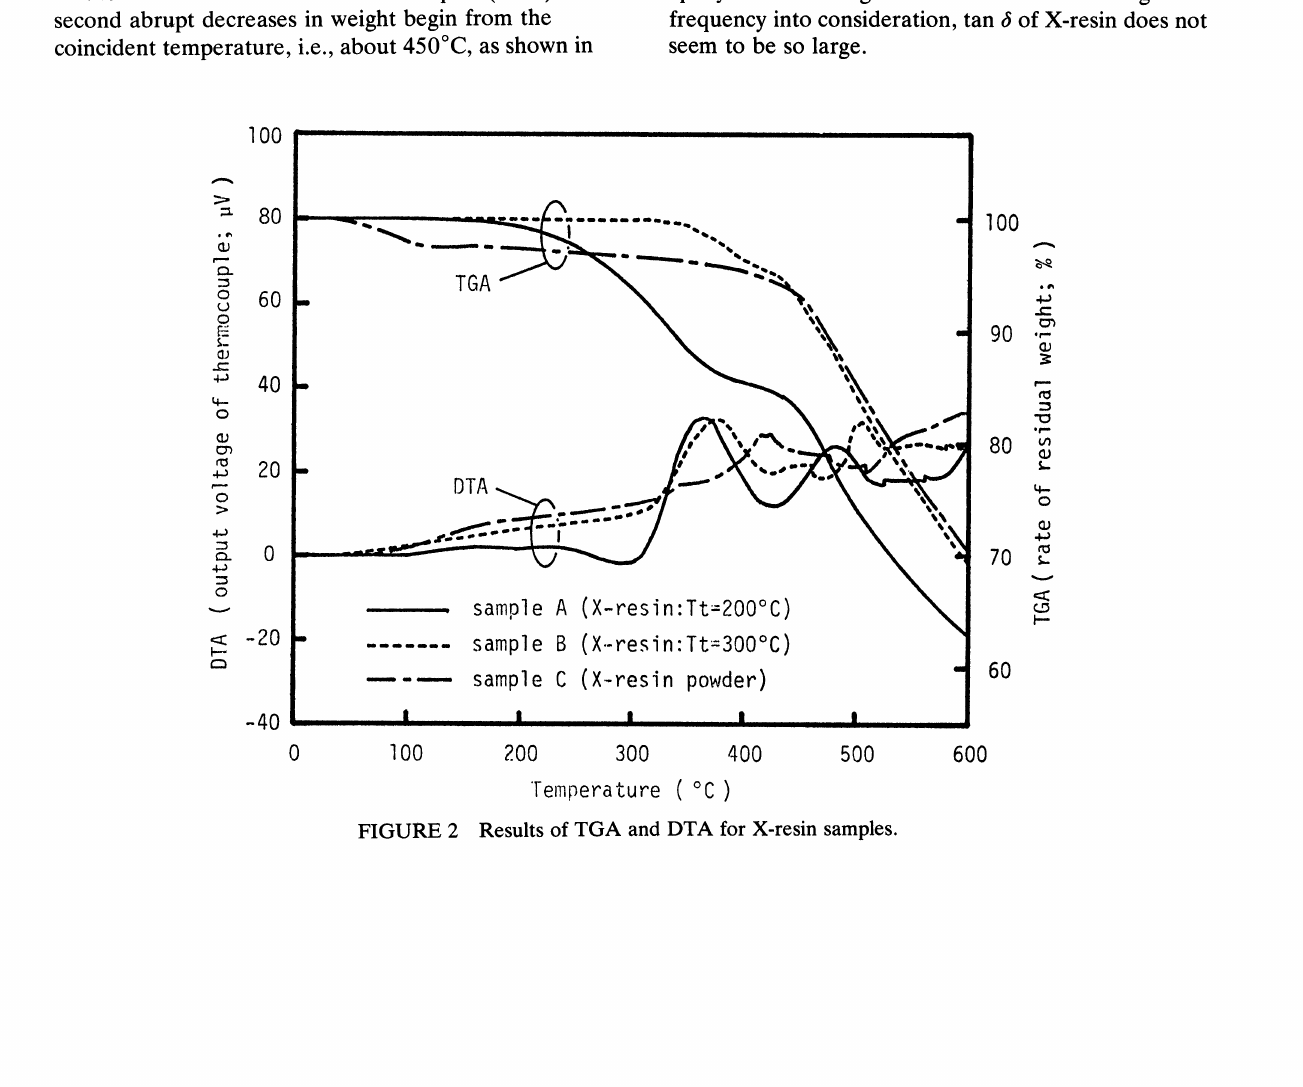
FIGURE 2 Results of TGA and DTA for X-resin